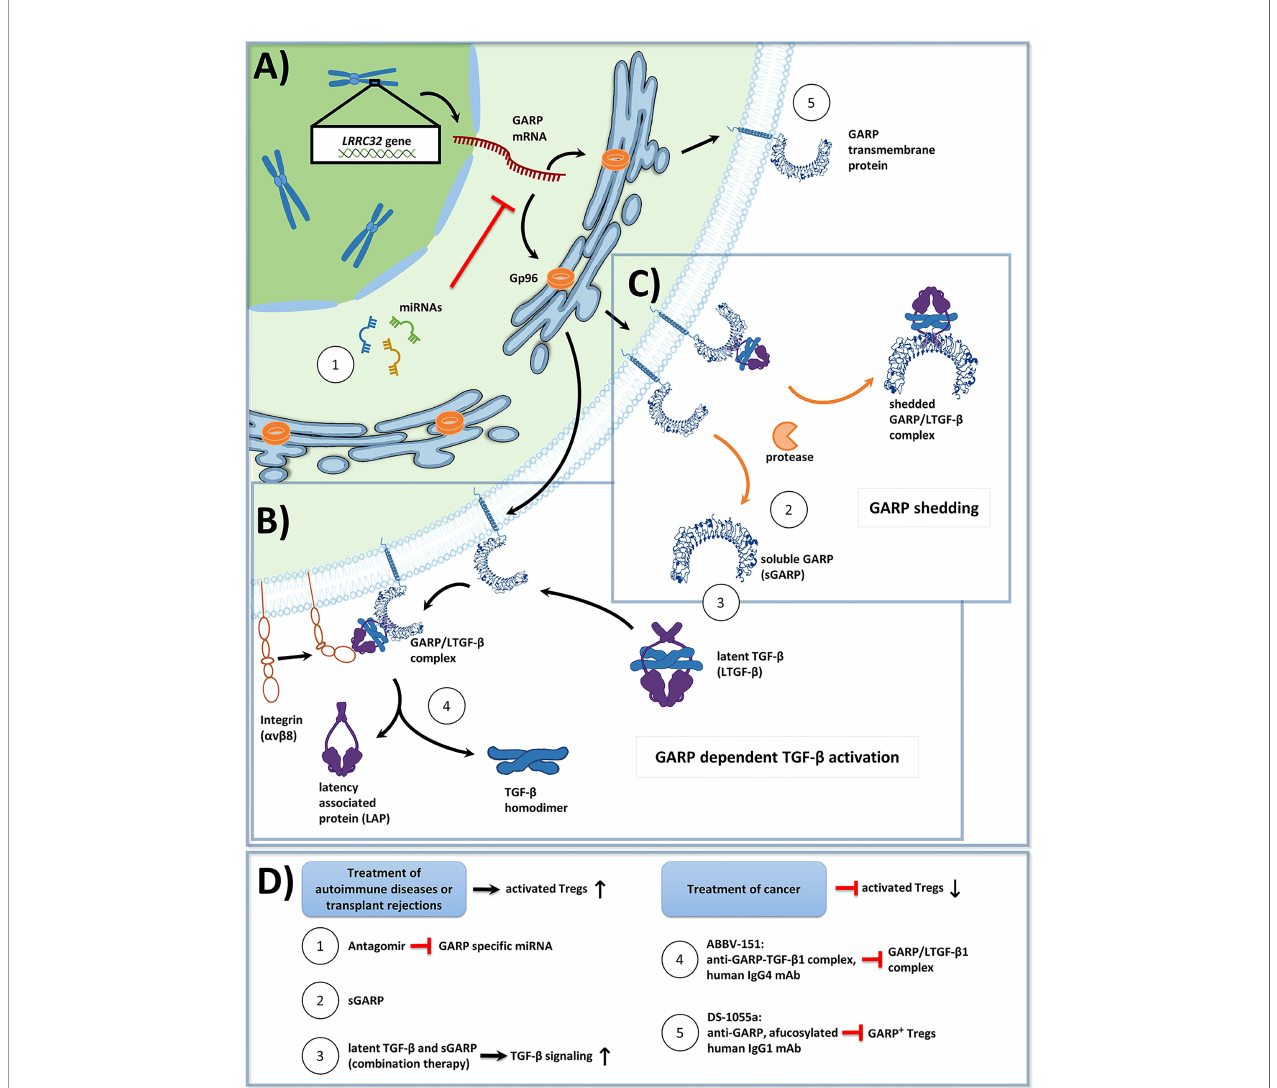
FIGURE 1 | (A) Overview of Glycoprotein a repetitions predominant (GARP) protein biosynthesis and transport to the cell membrane in activated human regulatory T cells (Tregs). GP96, a chaperone found in the endoplasmic reticulum, ensures proper folding of GARP [GARP structure modi fi ed from: Lie ́ nart et al. (35)]. The GARP mRNA is targeted by miRNA, which promote its degradation, and thus lower GARP mRNA/GARP levels. (B) GARP functions as a docking receptor for biologically inactive latent transforming growth factor beta (LTGF- b ), which consists of a TGF- b homodimer bound to latency associated protein (LAP), and GARP plays an important role in its activation. GARP binds LTGF- b with high af fi nity, forming the GARP/LTGF- b complex. Release of bioactive TGF- b can occur in both a protease independent (shown) or a protease dependent manner (not shown). For protease independent release of mature TGF- b , a V b 8 integrins, expressed on the surface of Treg bind to the GARP/LTGF- b complex, resulting in a conformational change and in the subsequent release of biologically active TGF- b . Alternatively, bioactive TGF- b can be released in a protease dependent manner, in which integrin recruited metalloproteinases or serine proteases cleave LAP from the GARP/ LTGF- b complex (not shown). (C) GARP can be cleaved from the surface of Treg by proteases in a form called soluble GARP (sGARP). GARP/LTGF- b complexes can also be released into the extracellular environment via proteases. (D) Potential methods to target GARP for the treatment of autoimmune diseases, transplant rejections, and cancer. Enhancing GARP mediated suppression by Treg offers a promising strategy for the treatment of autoimmune diseases and transplant rejections. (1) Approach 1 utilizes antagomirs, speci fi c to miRNA, which target the GARP mRNA. This would prevent GARP mRNA degradation, and thus increase surface GARP expression and enhance the suppressive capacity of Treg. (2) Approach 2 is to apply sGARP to induce Treg. (3) Approach 3 would be to apply sGARP in combination with LTGF- b to harness both their immunosuppressive effects and to promote the activation of TGF- b in an integrin-controlled manner. For effective anti-tumor immune responses to occur, Treg mediated suppression needs to be inhibited. (4-5) Approaches 4 and 5 represent two different monoclonal antibody (mAb) therapeutic strategies, that are currently in phase 1 clinical trials. (4) Approach 4 uses an IgG4 antibody (ABBV-151) that binds to the GARP/TGF- b 1 complex and prevents the release of mature TGF- b 1. This results in an inhibition of TGF- b 1 signaling, a subsequent decrease in the suppressive capacity of Treg, and the restoration of T effector cell (Teff) functions. (5) Approach 5 employs an afucosylated IgG1 antibody (DS-1055a), that ef fi ciently depletes GARP + Treg via antibody-dependent cellular cytotoxicity, preventing Treg mediated suppression and restoring Teff